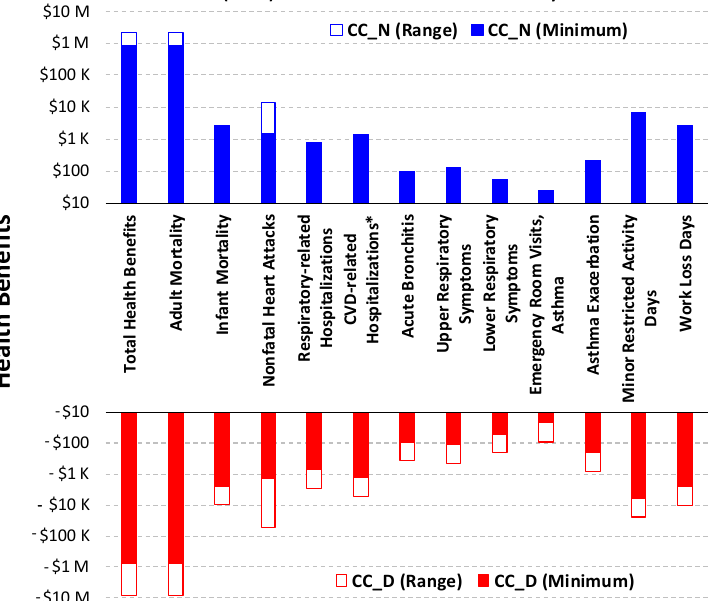
Figure 1. Annual health benefits in economic cost under CC_D and CC_N. The minimum and range are determined from the lower- and upper-bound estimates with both 3% and 7% discount rate (Supplementary Materials Tables S2–S4). M: millions. K: thousands. * Excluding heart attacks.